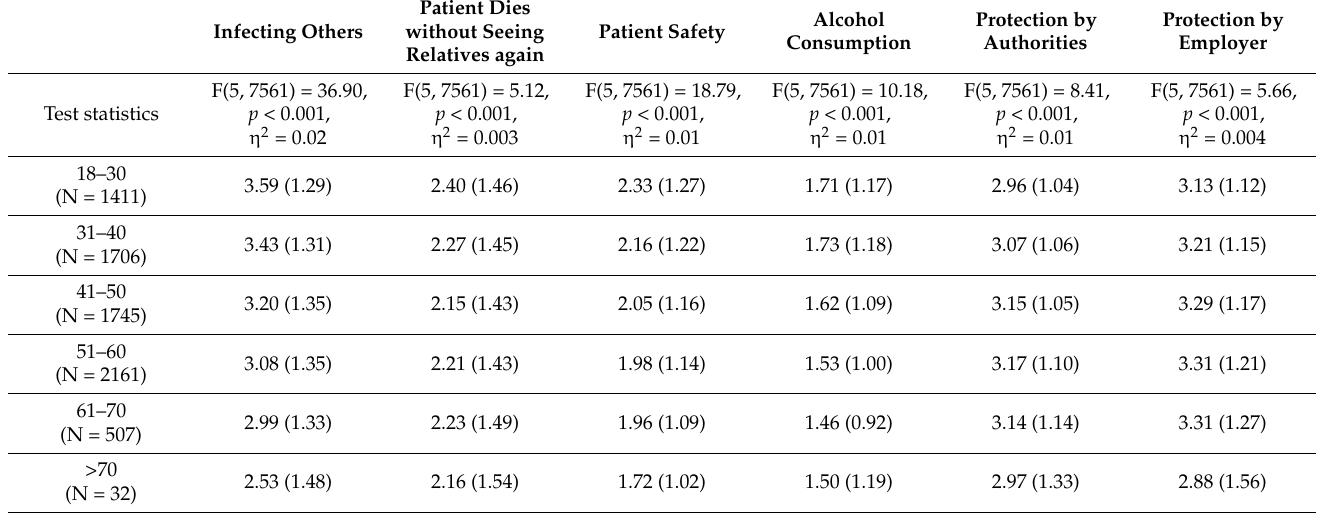
Table 5. Means and standard deviations for selected COVID-19-associated problem areas and related protective factors across different age